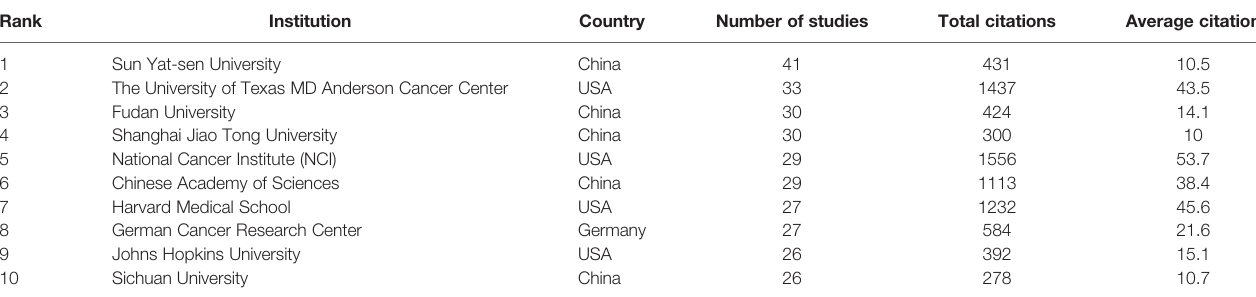
TABLE 2 | Top 10 institutions published literature related to colorectal cancer immunotherapy from 2010 to